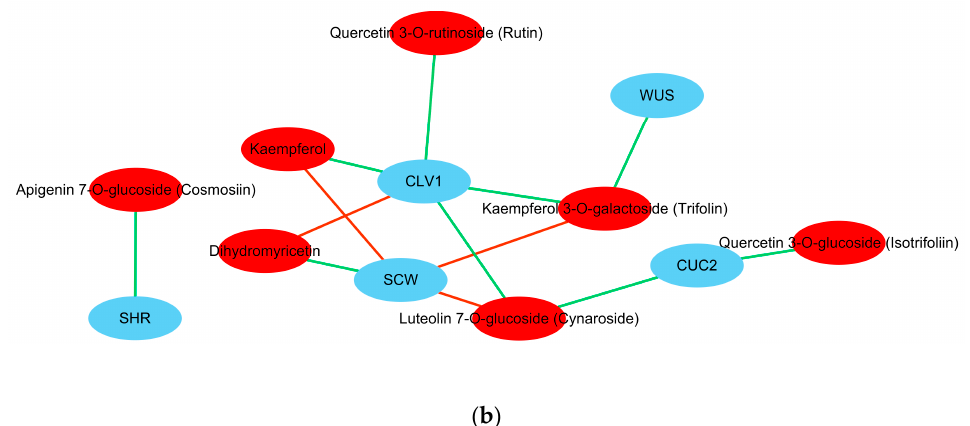
Figure 8. Transcript-metabolite correlation network representing DAMs and DEGs involved in PEC vs. NEC and GE vs. PEC. ( a ) Pearson correlation network representing factors associated with purine metabolism in PEC vs. NEC; ( b ) Pearson correlation network representing factors associated with flavonoid biosynthesis in GE vs. PEC. The gene-metabolite pairs were connected within the network by edges. Blue nodes represent genes and red nodes represent metabolites. Red edges represent positive correlations, and green edges represent negative correlations. DAMs, differentially accumulated metabolites; DEGs, differentially expressed genes; NEC, nonembryogenic staged calli; PEC, primary embryogenic calli; GE, initiation staged embryos with globular-like enriched.